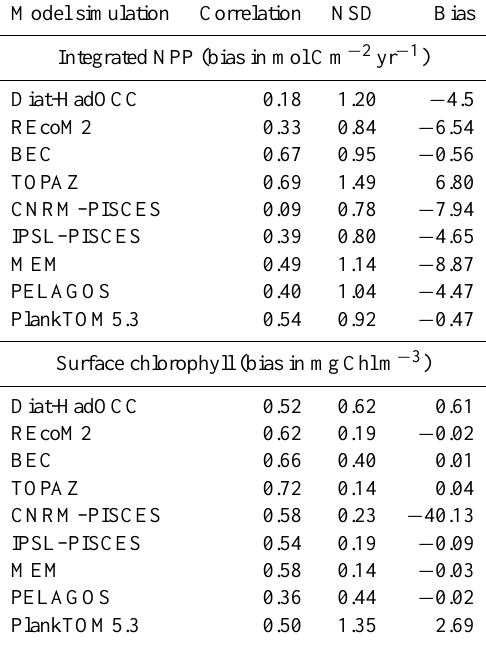
Table 7. Model skill in representing surface nutrients, mea- sured in Pearson correlation, normalized standard deviation (NSD) and bias. Nutrient data from Garcia et al. (2014). The